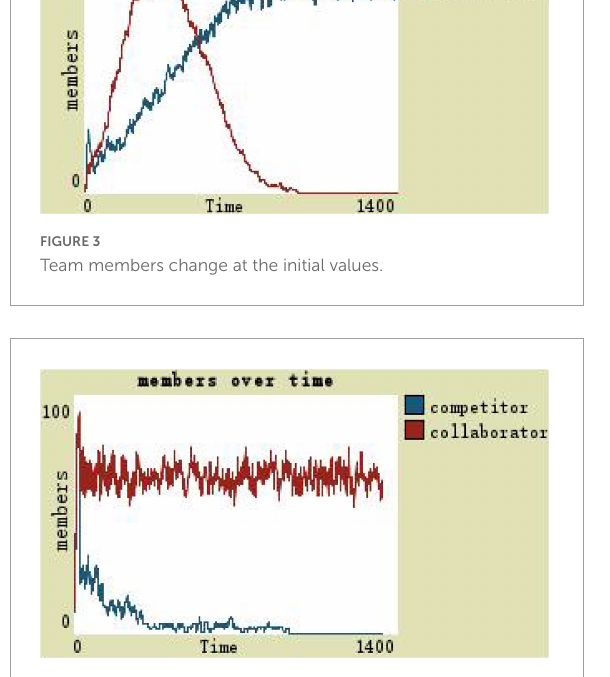
FIGURE4 Changes in team members with the participatory leadership.